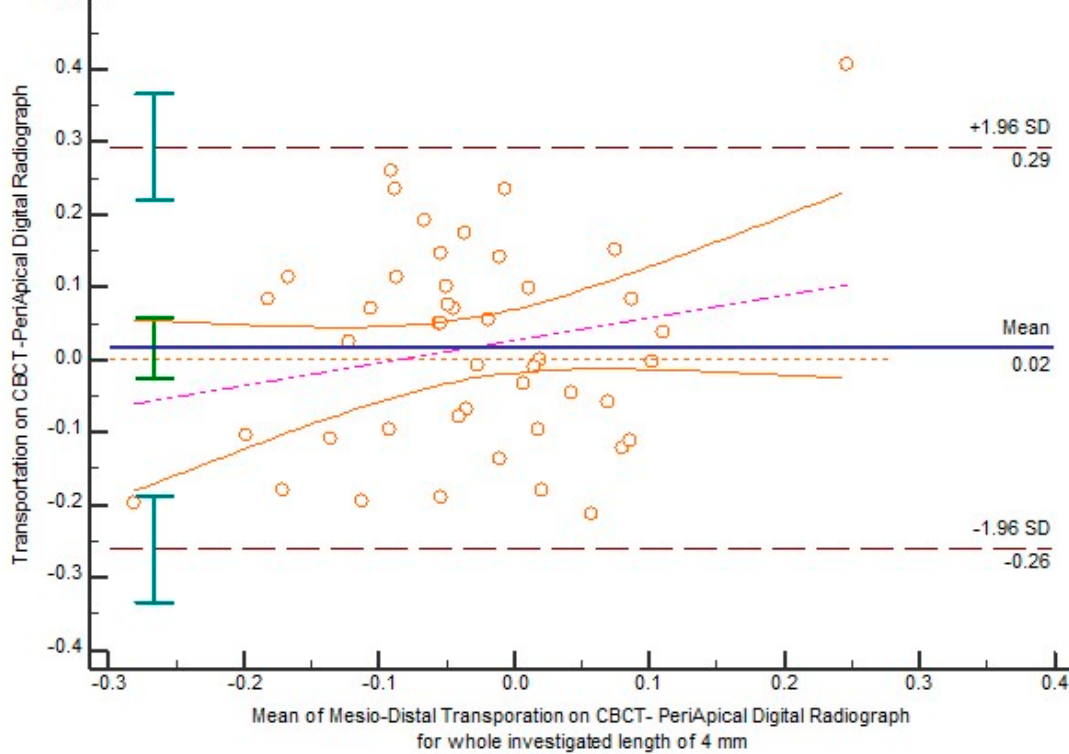
Figure 7. Bland–Altman plot for the agreement between the two methods’ measurements for the transportation in the mesio-distal direction, for the whole investigated length of 4 mm.